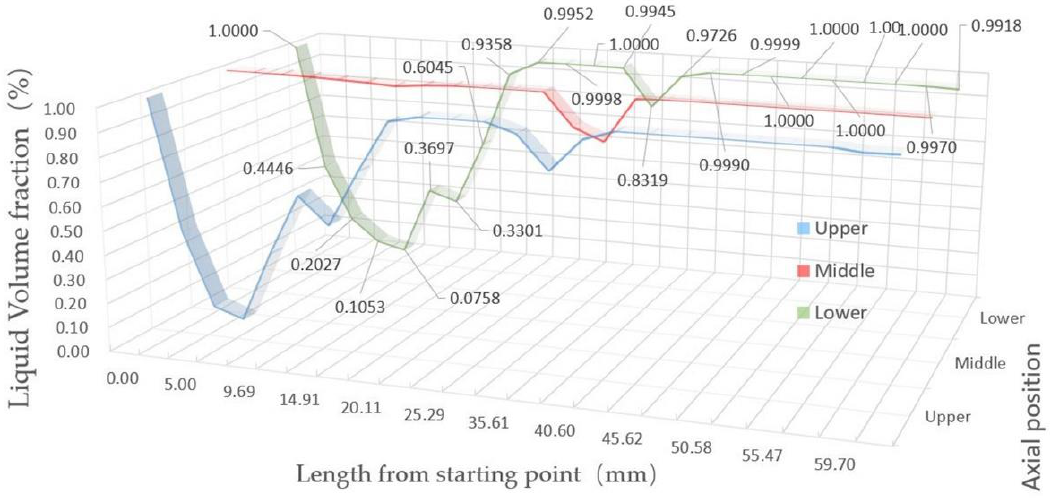
Figure 20. Distribution of liquid components at axial measuring points inside the impeller.